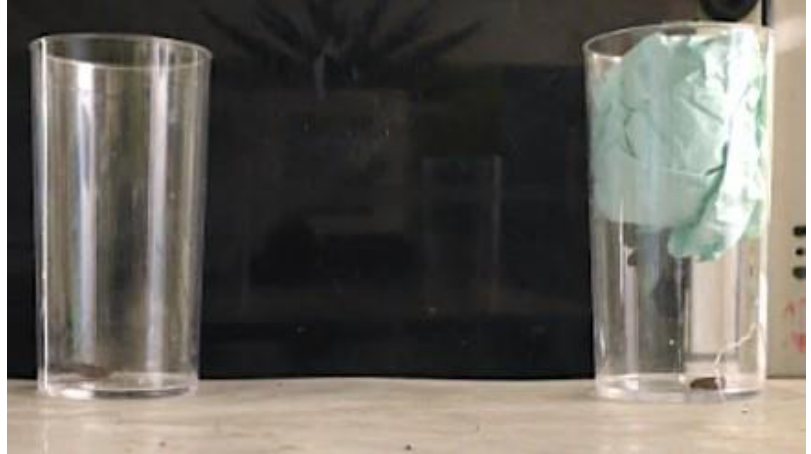
Photo of the Blocked Cups Set-Up for the Functional Condition